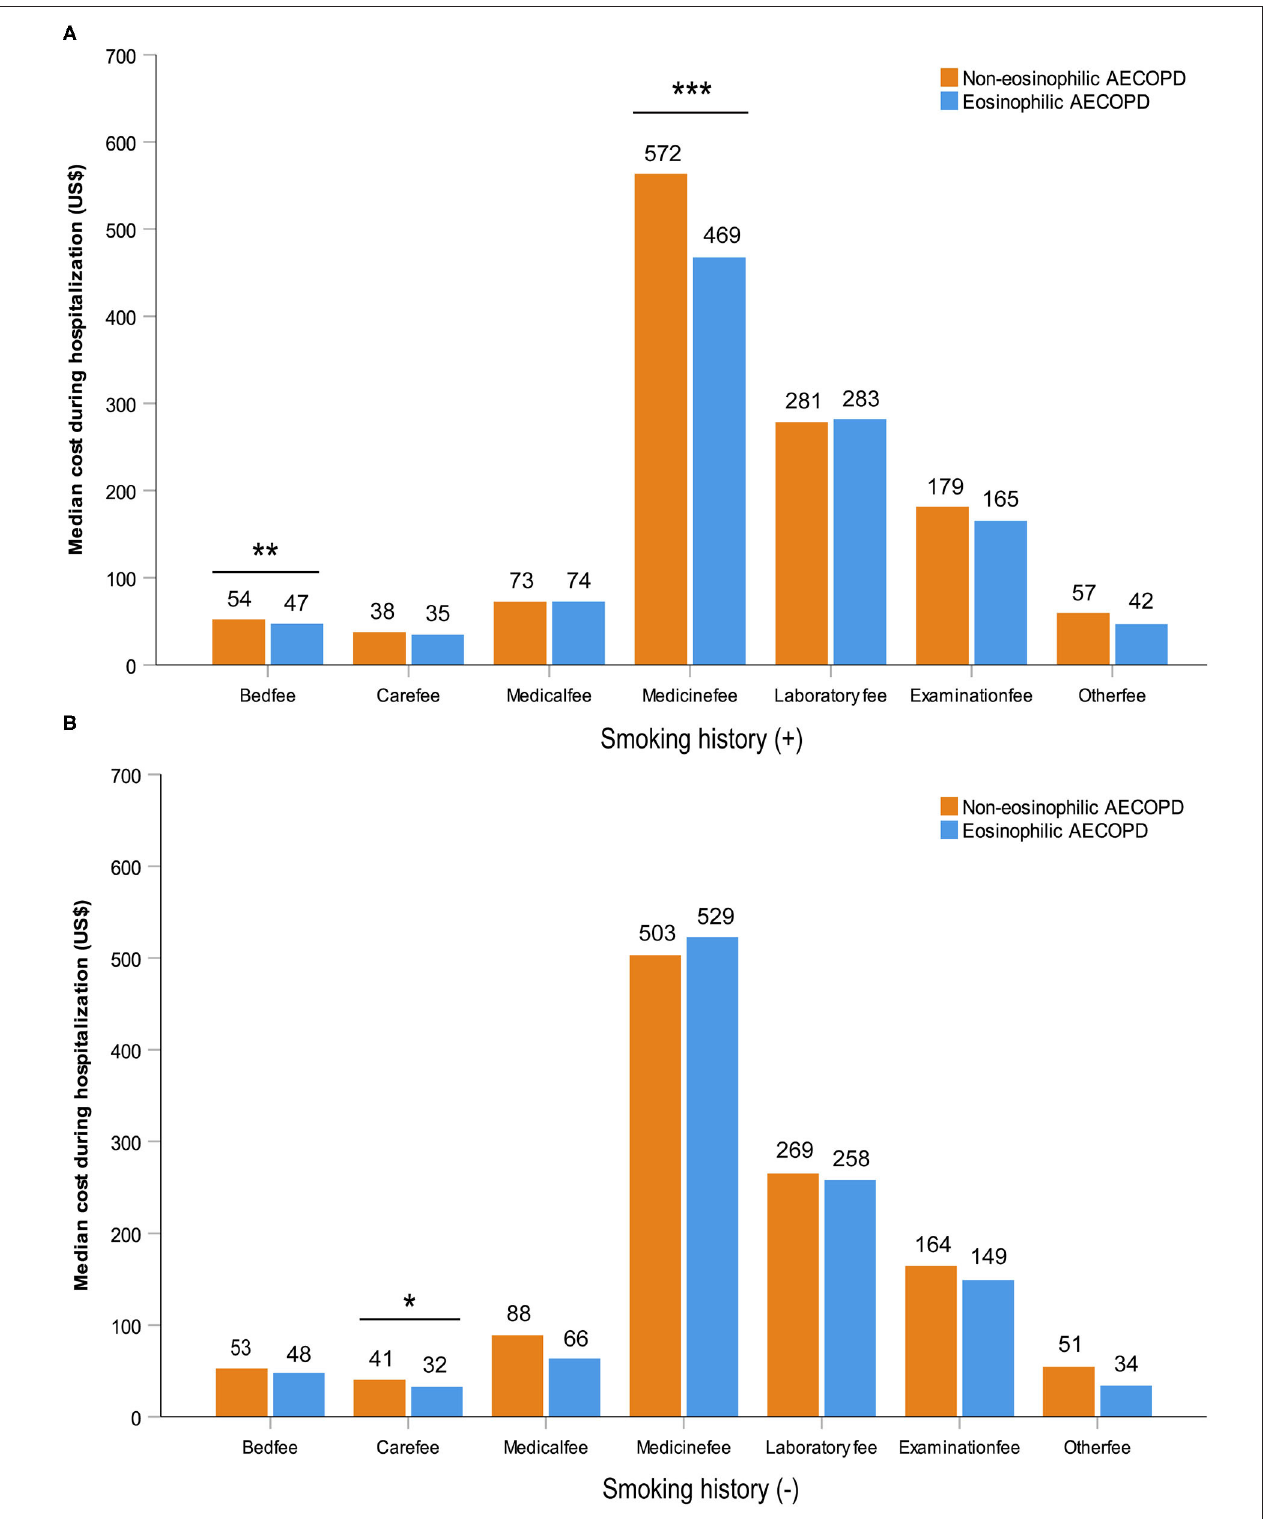
FIGURE 4 | Various cost during hospitalization in patients with or without smoking history after matching. Statistically significant differences between groups are indicated as * P ≤ 0.05, ** P ≤ 0.01, and *** P ≤ 0.001. Error bars show 95% confidence interval. AECOPD, acute exacerbations of chronic obstructive pulmonary